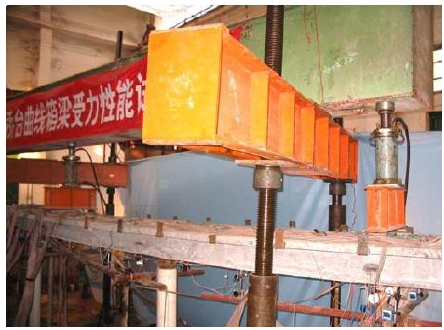
Figure 4. Experimental bridge model and loading apparatus.